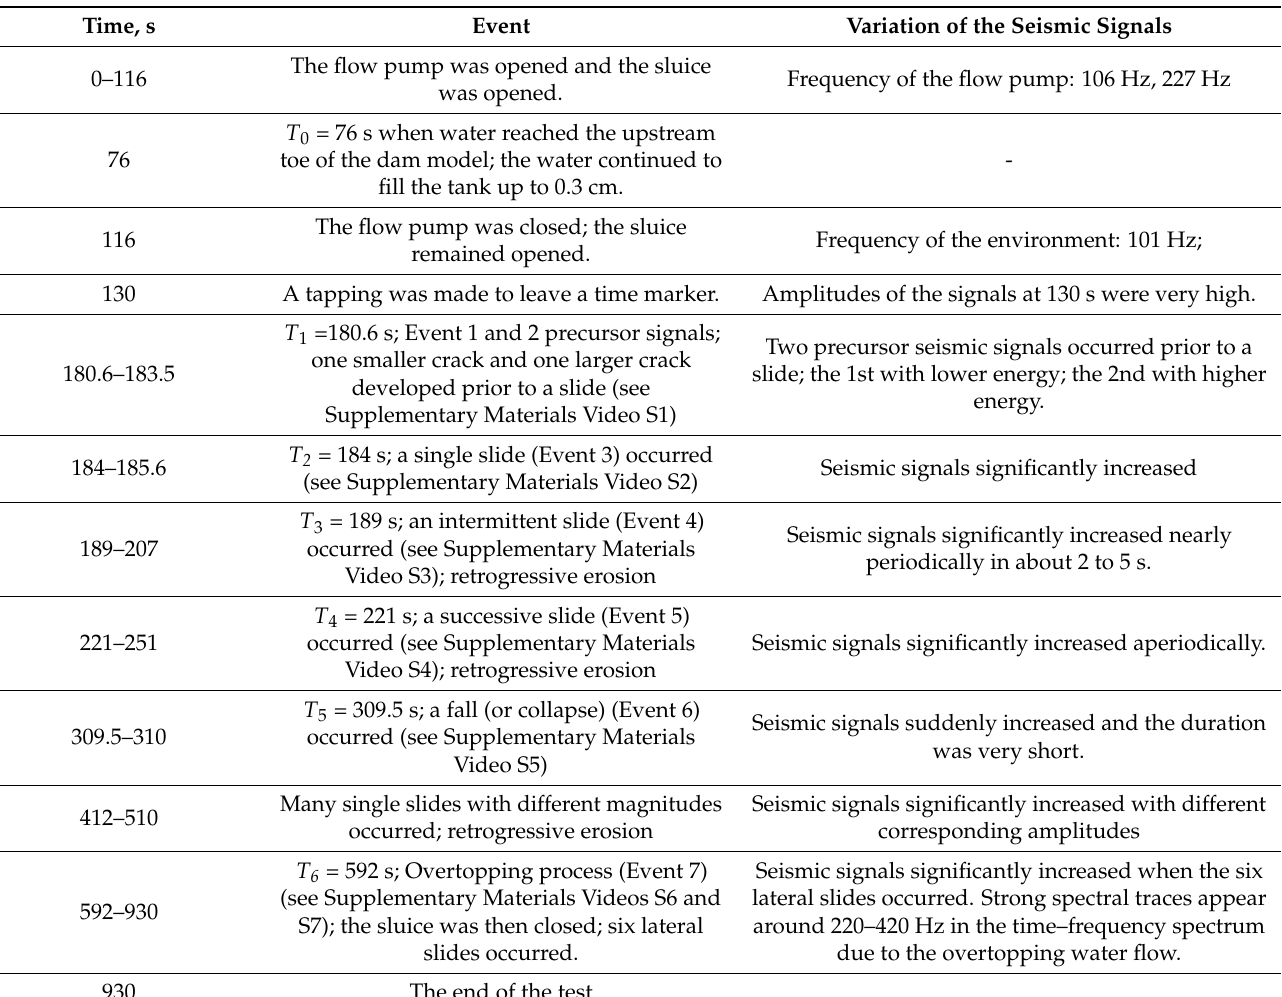
Table 2. Test processes and the selected important